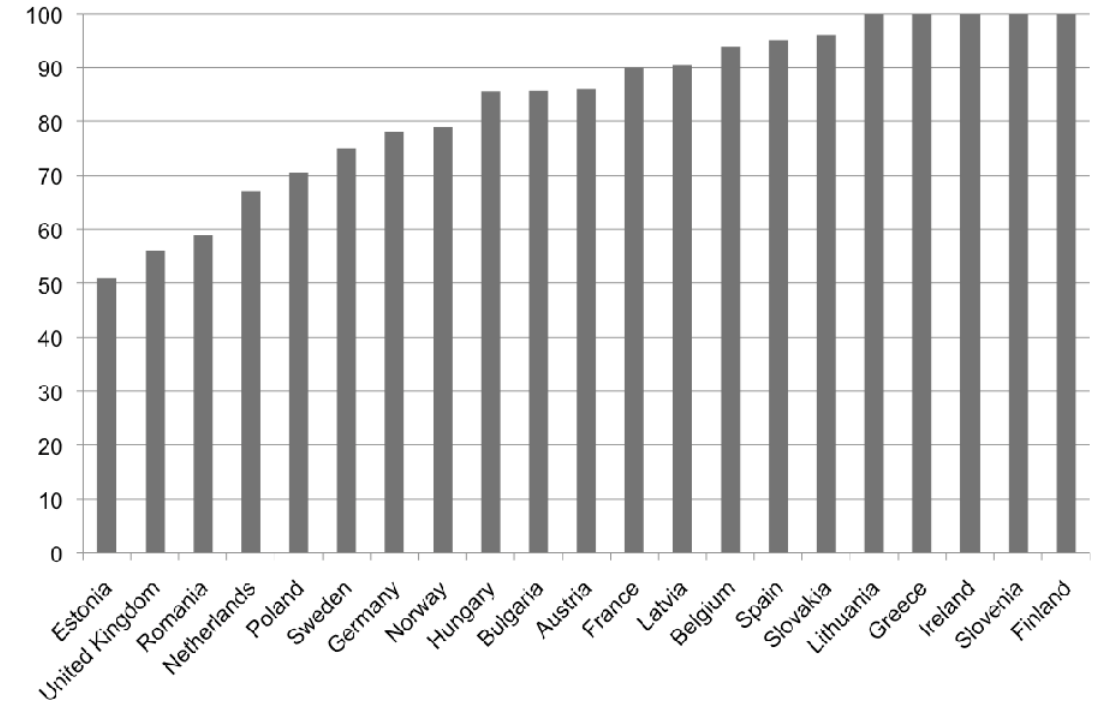
Figure 1. Incumbents’ market shares. (Adapted from source: European Commission, 2009) The United Kingdom and Sweden are often mentioned as pioneers in railway